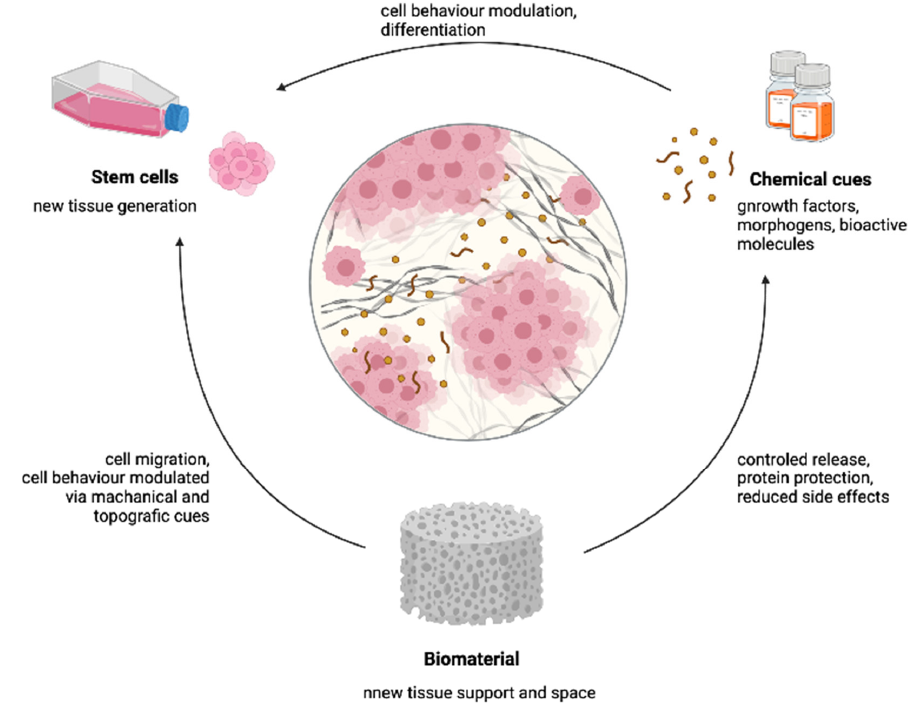
Figure 12. Shows the influence of individual components employed in tissue engineering and their influence on each other. Created using biorender.com (accessed on 14 April 2021).